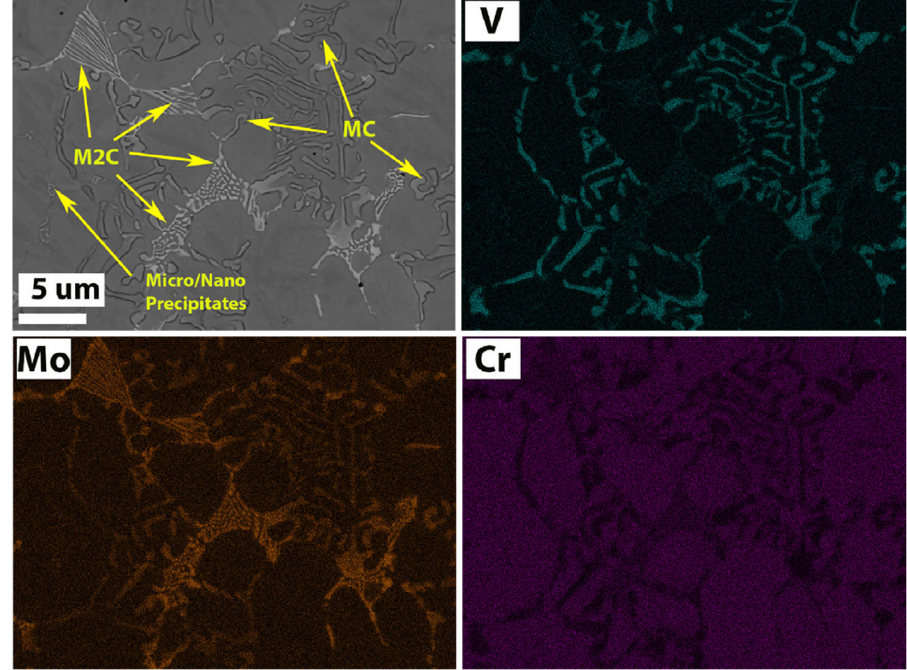
Figure 11. BSE-SEM images showing different carbides present in the laser cladded HSS alloys with EDS images [37].